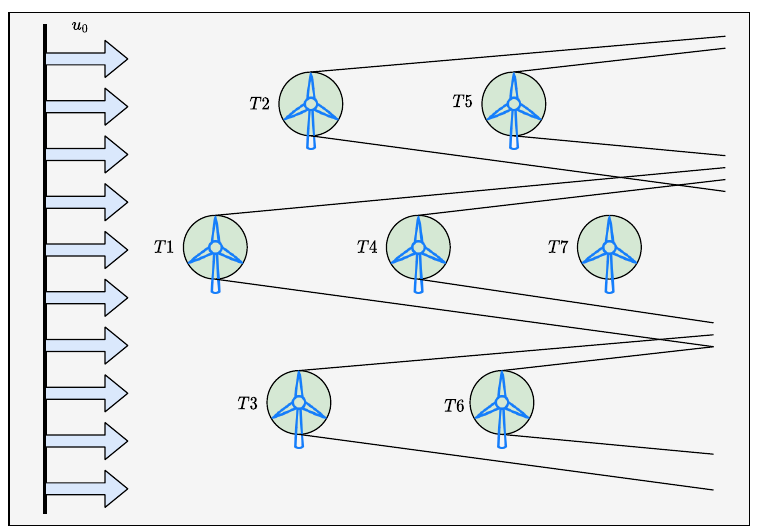
Figure 9. The velocity profile behind WT [85].